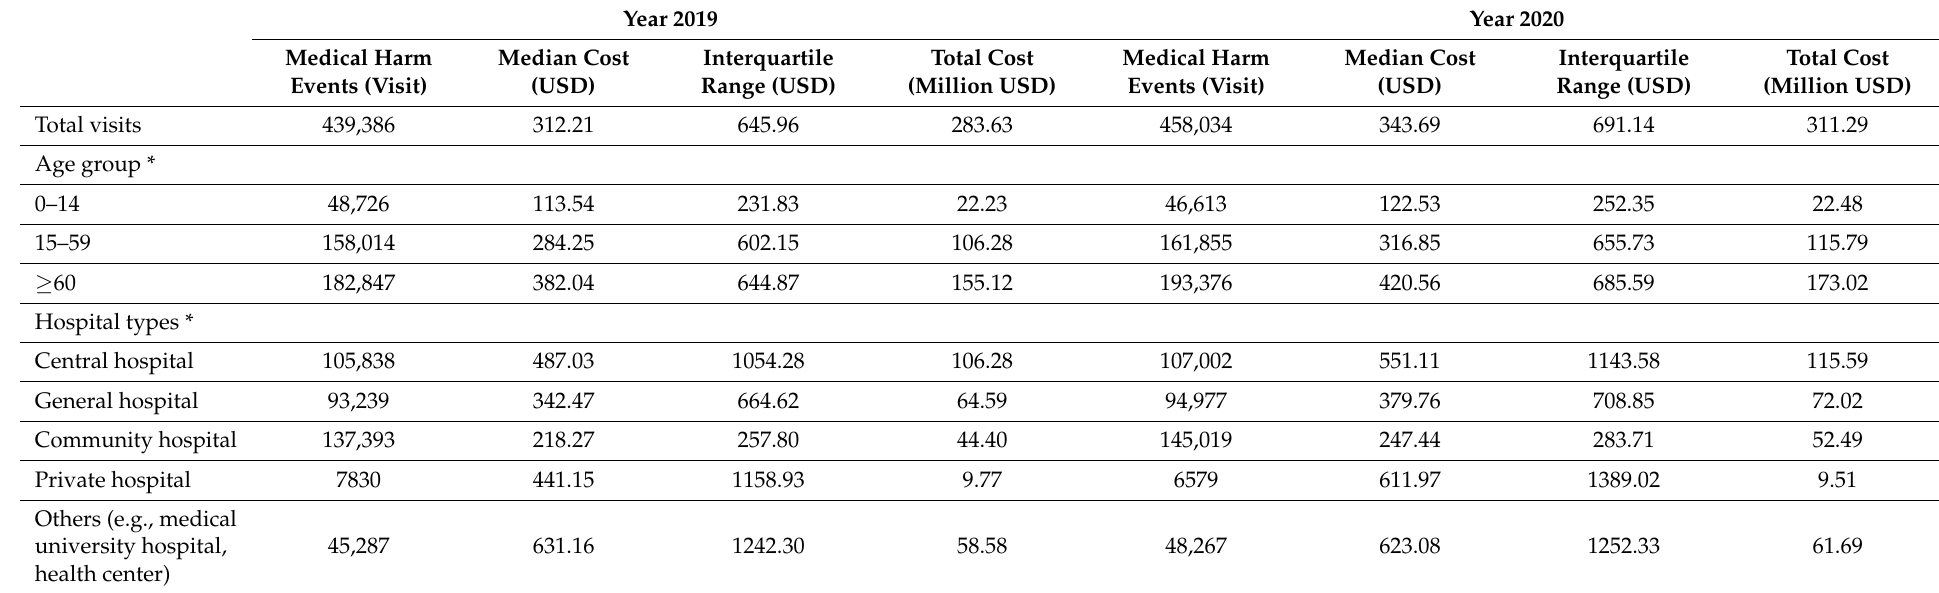
Table 4. Estimated cost burden of medical harm in each group between 2019 and